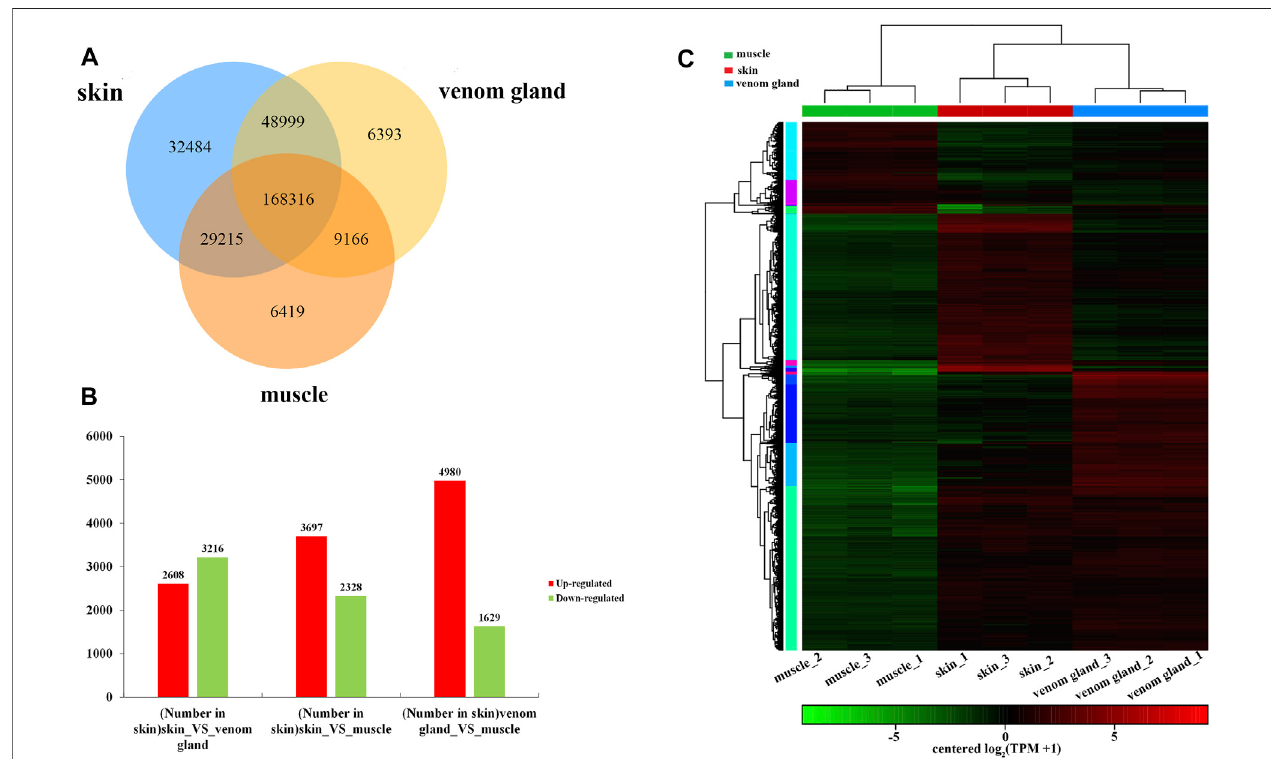
FIGURE3| AnalysisofDEGsinthetranscriptomedata. (A) Venndiagramrepresentsthenumberofdifferentialexpressiongenesamongthreetissues:skin,venom gland, and muscle. (B) The number of upregulated and downregulated genes of in each tissue compared with two other tissues. (C) The clustering heat map of differential gene